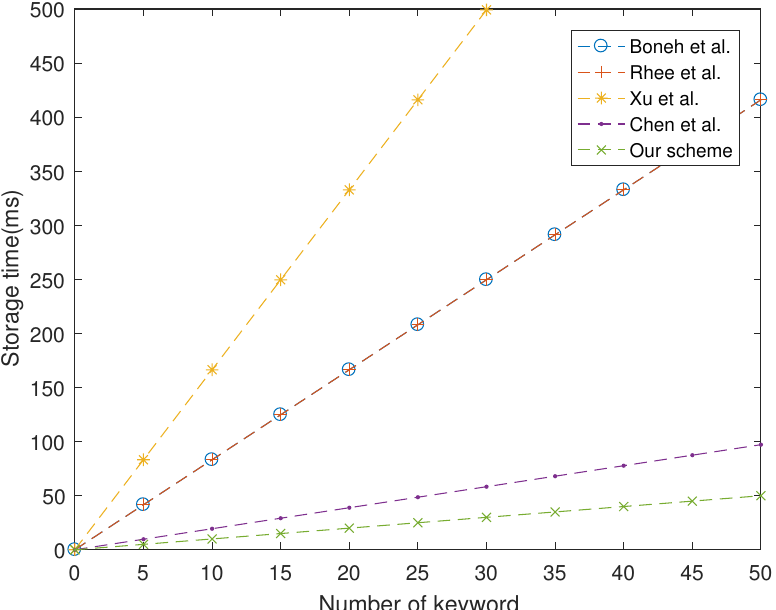
Figure 1. Computation cost at storage phase.